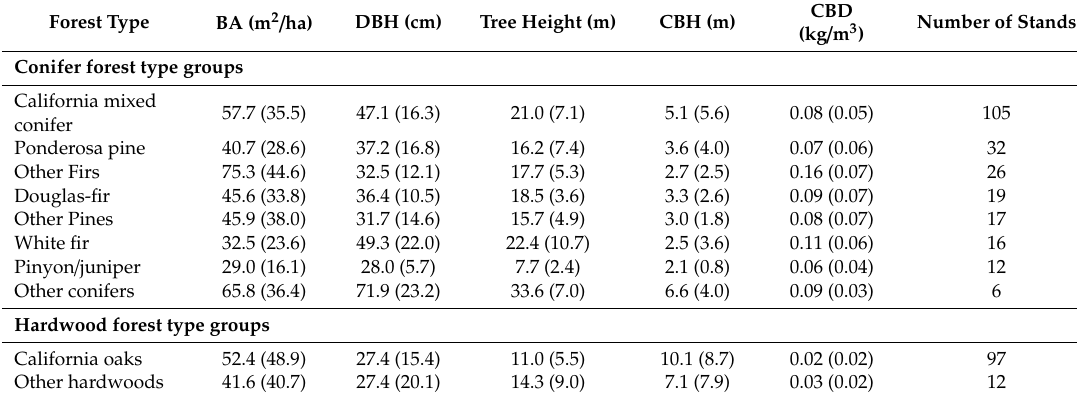
Table 1. Mean and standard deviation (in parentheses) by forest type group of pre-fire stand basal area (BA), diameter at breast height (DBH), and tree height from inventory data; Fire and Fuels Extension (FFE) calculated canopy base height (CBH) and bulk density (CBD); and number of fire-a ff ected Forest Inventory and Analysis( FIA) stands, defined as conditions (see